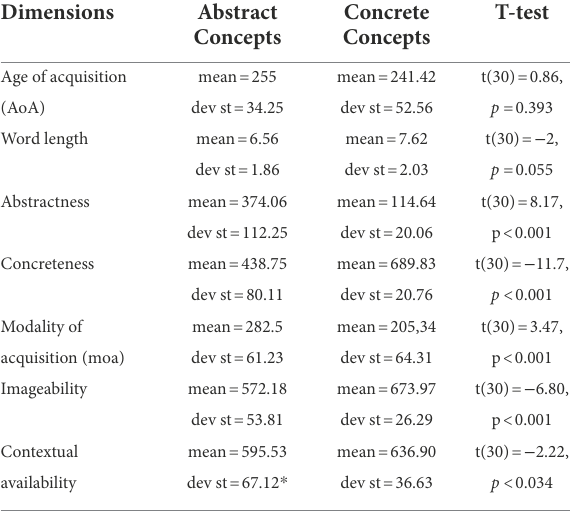
TABLE 2 Dimensions of abstract and concrete selected words. concrete and abstract concepts did not differ for familiarity, age of acquisition, and word length